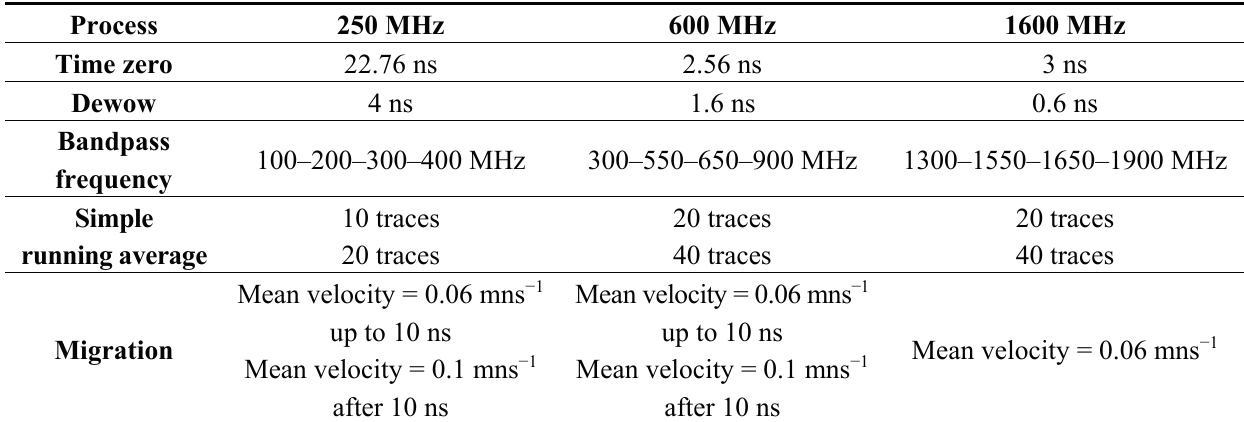
Table 1. GPR processing procedures and parameters used for each frequency with ReflexW